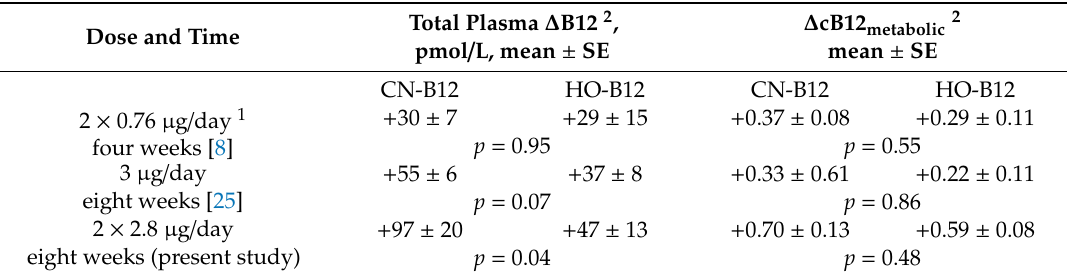
Table 4. Final changes in total plasma B12 and the combined metabolic index following administration of CN-B12 and